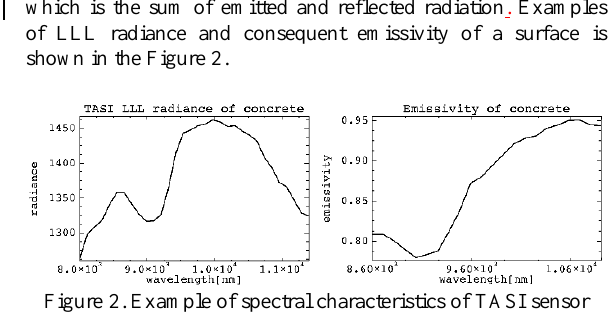
Figure 2. Example of spectral characteristics of TASI sensor after